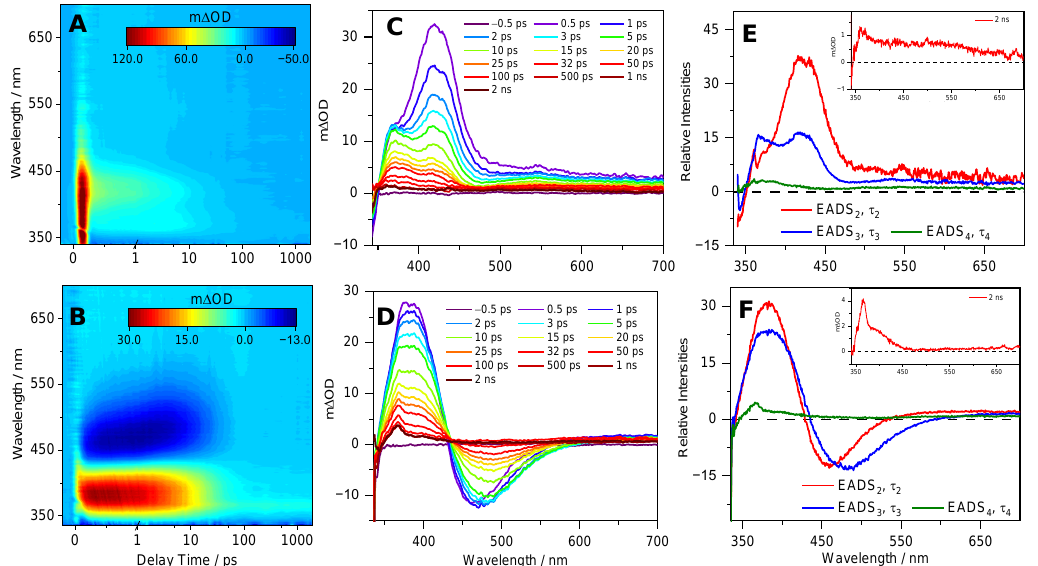
Figure 3. TEA spectra obtained for 0.1 g of cress sprout extract in 25 mL of ( A ) dioxane and ( B ) water, photoexcited at 330 nm, with spectra presented as false colour maps. The same data are presented as line plots of mΔOD vs. probe wavelength at selected pump–probe delay times in ( C , D ) for cress sprout extract in dioxane and water, respectively. ( E , F ) The evolution associated difference spectrum (EADS) for cress sprout extract in dioxane and water, respectively, produced by the fitting procedure. The inset ( E , F ) shows the transient absorption spectrum at the maximum available pump–probe delay of 2 ns.